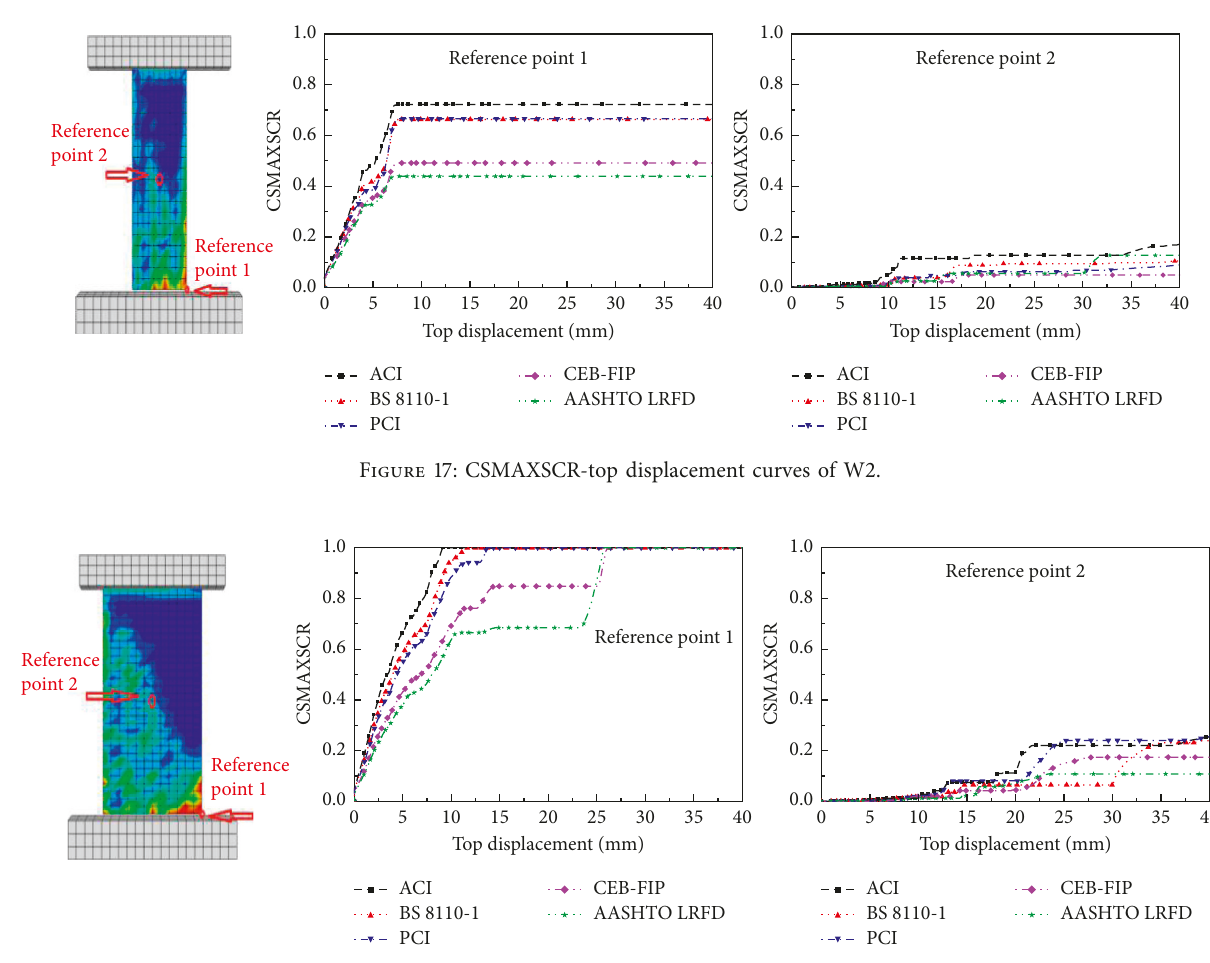
Figure 18: CSMAXSCR-top displacement curves of W3. Table 5: Comparison of the ultimate bearing capacity based on different design codes under 0.3 axial compression ratio. Design